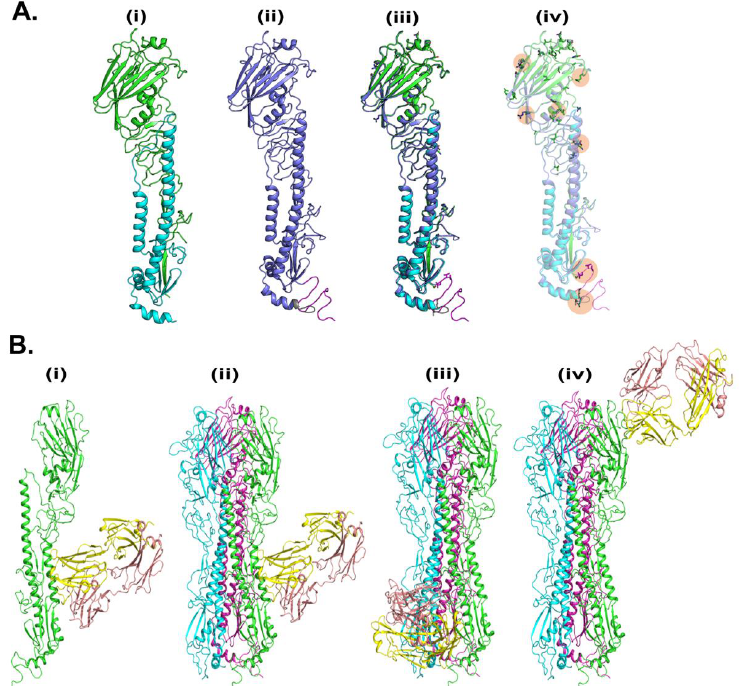
Figure 7. In-silico analysis of HA-T-AGM. ( A ). Molecular modeling of HA-T-AGM protein and structural comparison with reported structures: ( i ) Crystal structure of pdb-id 4LVX, including chain A (green) and chain b (cyan) ( ii ). Model of HA-T-AGM (blue) ( iii ) The overlay structure be- tween crystal and model and ( iv ) The overlay structure (in transparent), to show the changes in amino acids (in licorice). ( B ). Molecular Docking of HA-T-AGM with reported mAb: ( i ) monomer chain (in green) with the most likely pose of mAb (pdb-id 3SDY) (yellow and magenta) ( ii ). Trimer Model of HA in protomer 1 (green), protomer 2 (cyan), and protomer3 (purple) highlighted the most likely pose is consistent in trimer as well ( iii ) 2nd pose of mAb in trimer and ( iv ) 3rd pose of mAb in the trimer . 4. Discussion Despite the extensive antigenic variability of Influenza HA structural protein, this is the major antigen that confers protection against Influenza viruses [42]. Current licensed seasonal vaccines are also focused on the protective ability of the HA glycoprotein to elicit potent neutralizing responses, although these vaccines confer only strain-specific protec- tion [43]. An ideal vaccine for Influenza should have a greater breadth of protection and should be suitable for all age groups. Novel and promising approaches are currently un- der evaluation for the development of next-generation universal vaccines [44]. However, the old paradigm of using recombinant subunit HA-based vaccine against the seasonal or pandemic virus strain remains a lucrative approach [45,46]. The subunit vaccine elimi- nates the concerns of some of the whole virus-based vaccines such as egg-based allergy, pre-existing immunity, and improper inactivation [47]. For Influenza viruses, several HA- based subunit vaccines have been evaluated which provide various levels of protection and breadth [26,48,49]. It has been well-documented that the HA globular head-based vaccines are more protective than stem-based vaccines alone [50].